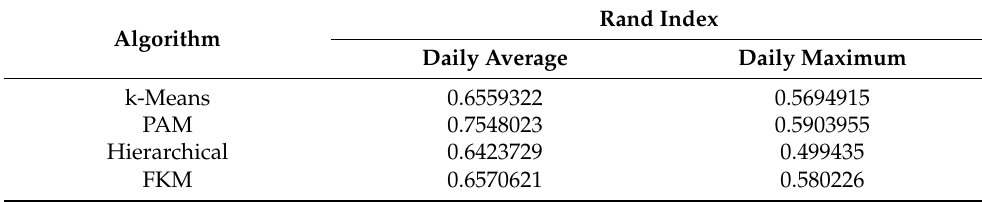
Table 7. Rand Index values for daily average and daily maximum data for k-Means, PAM, hierarchical, and FKM. Rand Index Algorithm Daily Average Daily Maximum k-Means 0.6559322 0.5694915 PAM 0.7548023